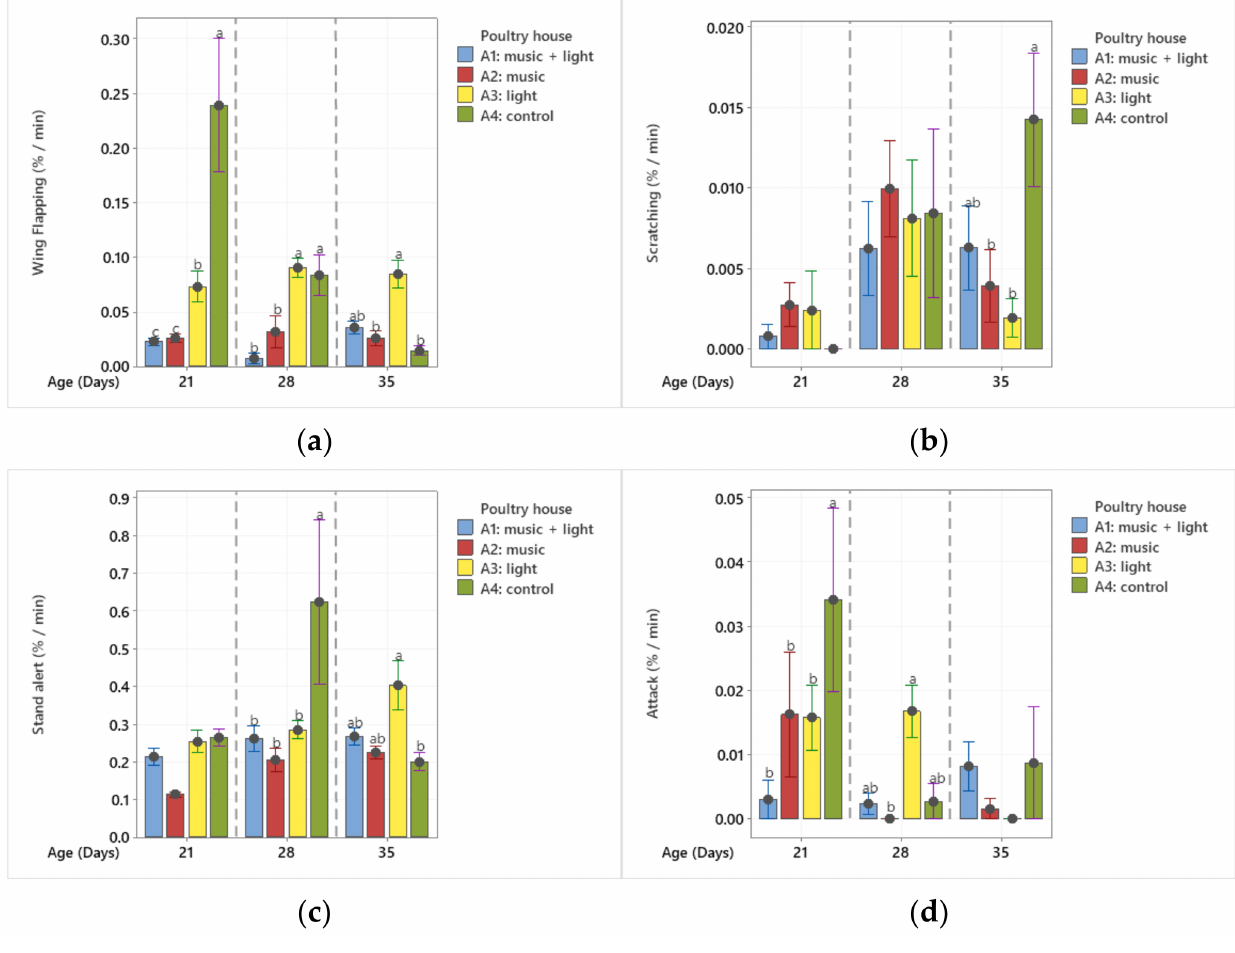
Figure 4. Graphs of means and respective standard errors of the observed behaviors over six minutes for behaviors (( a ) wing-flapping, ( b ) scratching, ( c ) standing alert, and ( d ) attacking) and the result of the Fisher test significance ( p < 0.05) for each evaluated